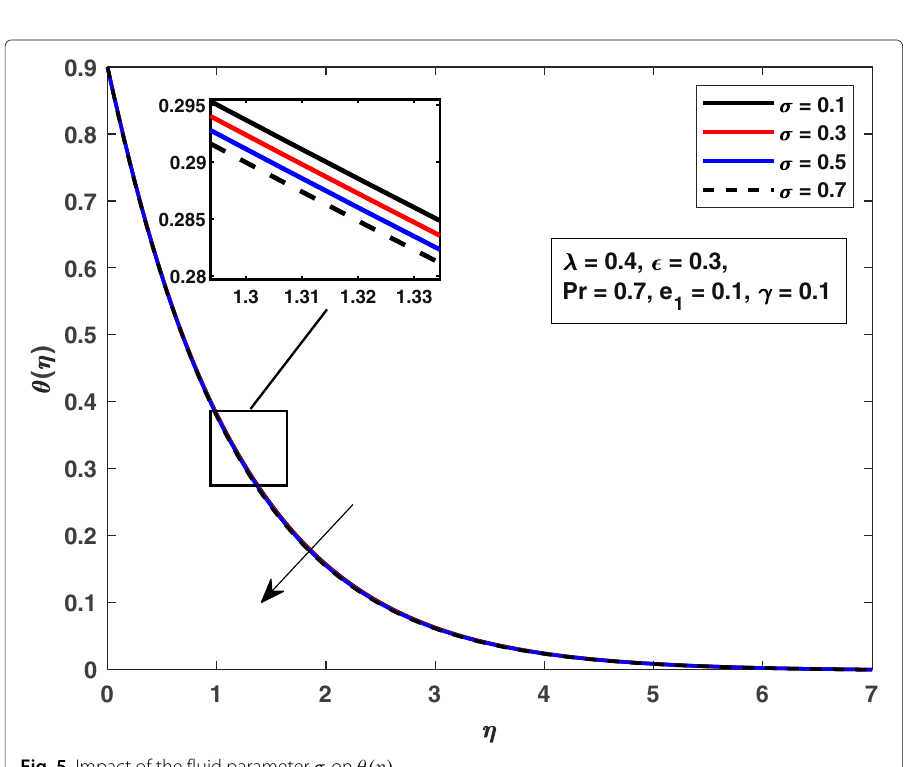
Fig. 4 Impact of the fluid parameter σ on f (cid:6) (η)